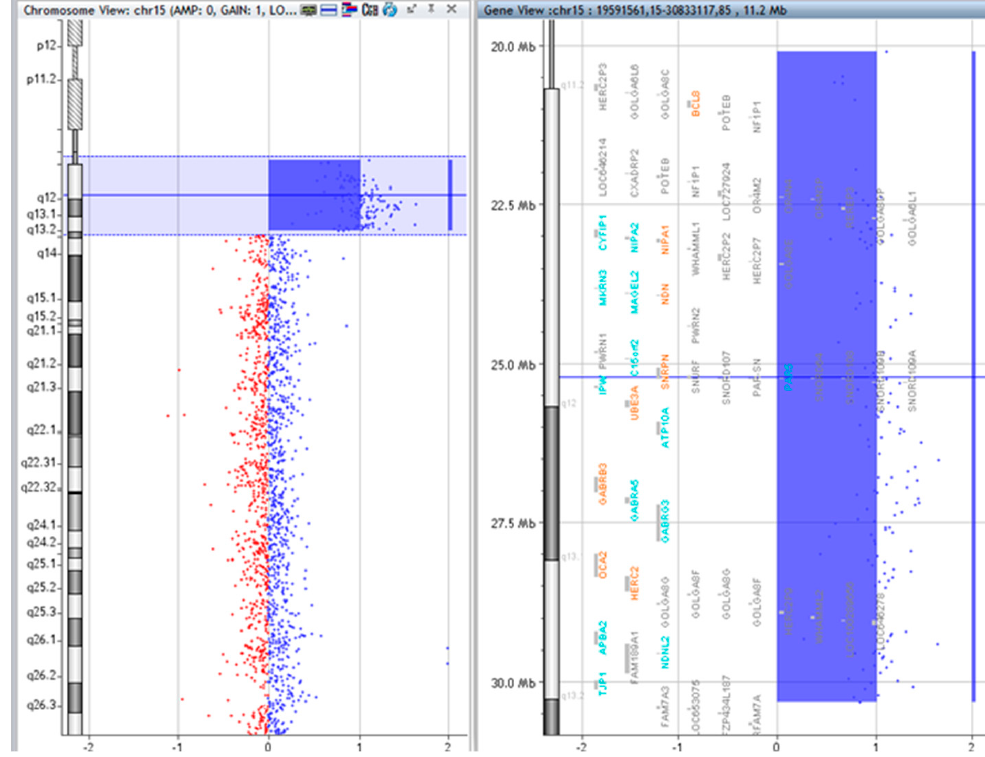
Figure 2. Array comparative genomic hybridization (CGH) results of